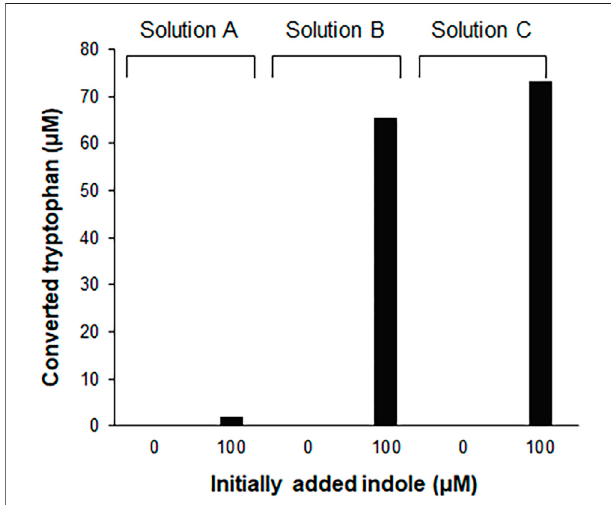
FIGURE 1 | Conversion of indole to tryptophan in the S12 extract solutions. 100 μ M indole was incubated for 2 h at 30 ° C, in the S12 extract diluted indifferentsolutions[27%(v/v)].SolutionA,S12extractdilutedinPBS; solution B, S12 extract diluted in the reaction mixture containing CFPS components prepared in the absence of tryptophan and template DNA; solution C, solution B without amino acids. Concentrations of tryptophan converted from indole were measured using a Hitachi L-8900 amino acid analyzer (Hitachi High-Technologies, Tokyo, Japan) following the manufacturer ’ s